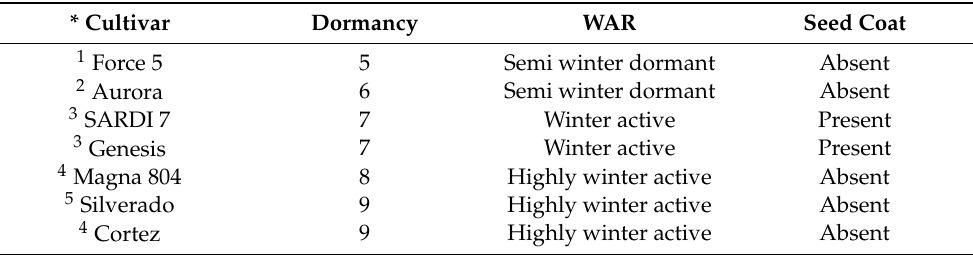
Table 3. Lucerne cultivars utilized in the glasshouse experiment with respect to dormancy, winter activity rating (WAR) and presence of seed coat (nitrogen inoculation) pre-planting. * Cultivar Dormancy WAR Seed